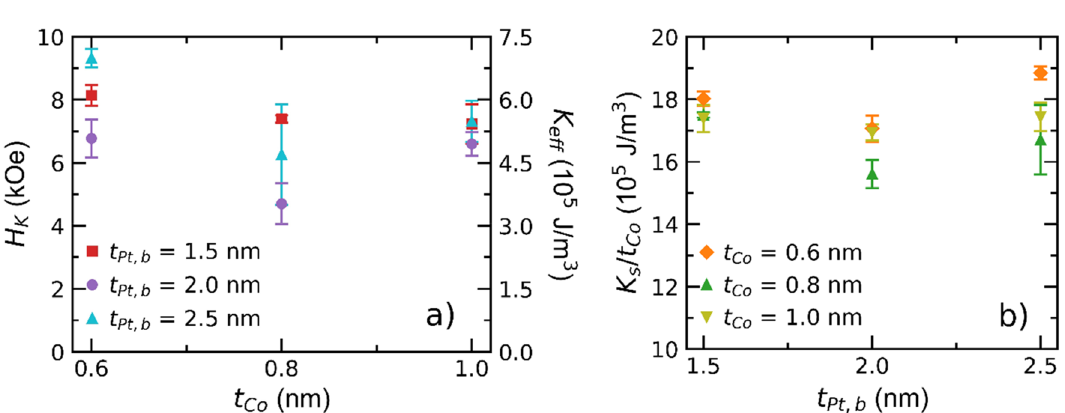
Figure 7. Magnetic characteristics Nb(15)/Pt( t Pt , b )/Co( t Co ) /Pt(1.5)/MgO(3) samples, derived from magnetoresistance Hall measurements. Fields have been applied in-plane and swept at 200 Oe/s. ( a ) Perpendicular anisotropy field, H K , (left axis) estimated from the hard-axis saturation field i.e. an in-plane applied field hall measurement, and the corresponding net anisotropy, K eff , (right axis) as a function of cobalt thickness, t Co , for each bottom Pt thickness. ( b ) Surface anisotropy per unit cobalt thickness, K s / t Co , as a function of bottom Pt thickness, for the same samples as in ( a